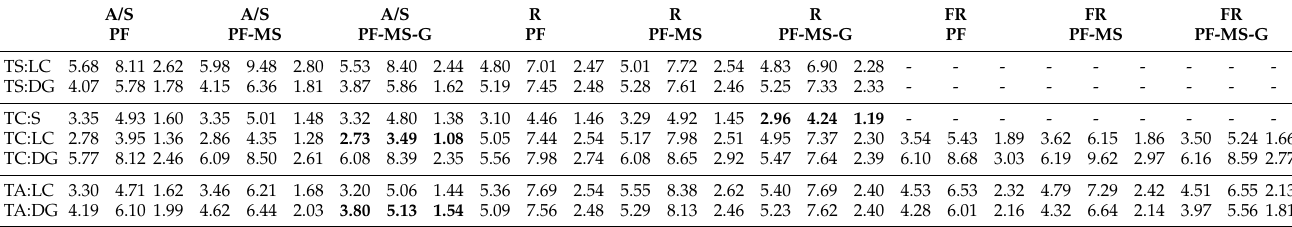
Table 4. Reconstruction errors ( RMSE wp , Hauss, avHauss ) using the map-assisted path reconstruction algorithms described in Section 4.4.3. Units of meters. For each community of walkers (S, LC, DG), the smallest error values for each metric are shown in